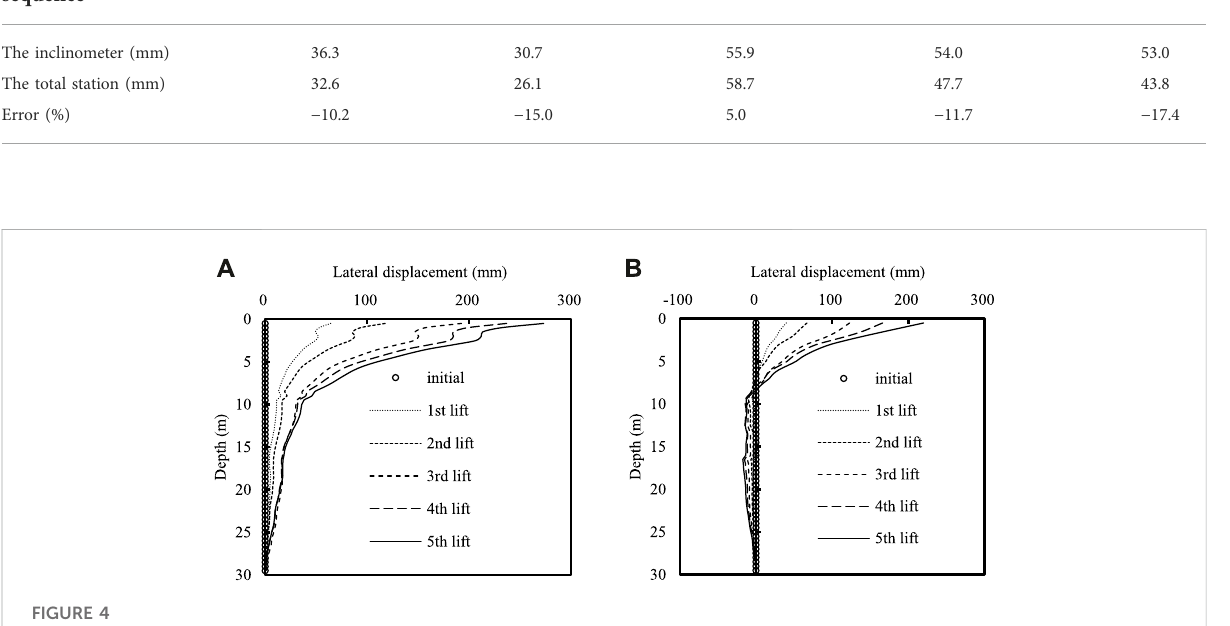
TABLE 3 Comparison of the increment of the horizontal displacement measured by different methods. Construction